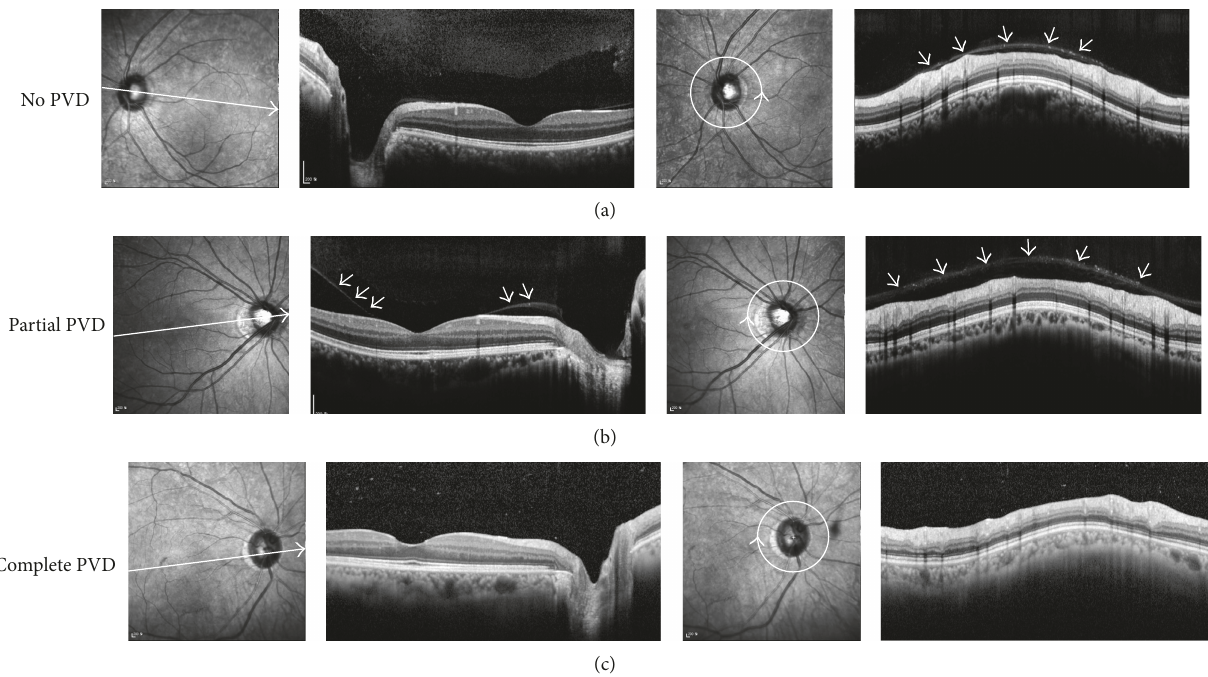
Figure 2: Posterior vitreous detachment grading by optical coherence tomography. Posterior vitreous status was graded with optical coherence tomography. (a) No posterior vitreous detachment (PVD), with complete attachment of the posterior vitreous cortex (PVC) to the perifoveal area, fovea, and optic disc. Circumferential peripapillary scan also con fi rms attached PVC (arrows). (b) Partial PVD with separation of the PVC over perifoveal area (arrows). Circumferential peripapillary scan shows attached PVC (arrows). (c) Complete PVD with detachment of PVC over perifoveal area, fovea, and optic disc, showing optically empty space above. Circumferential peripapillary scan also lacks attached overlying